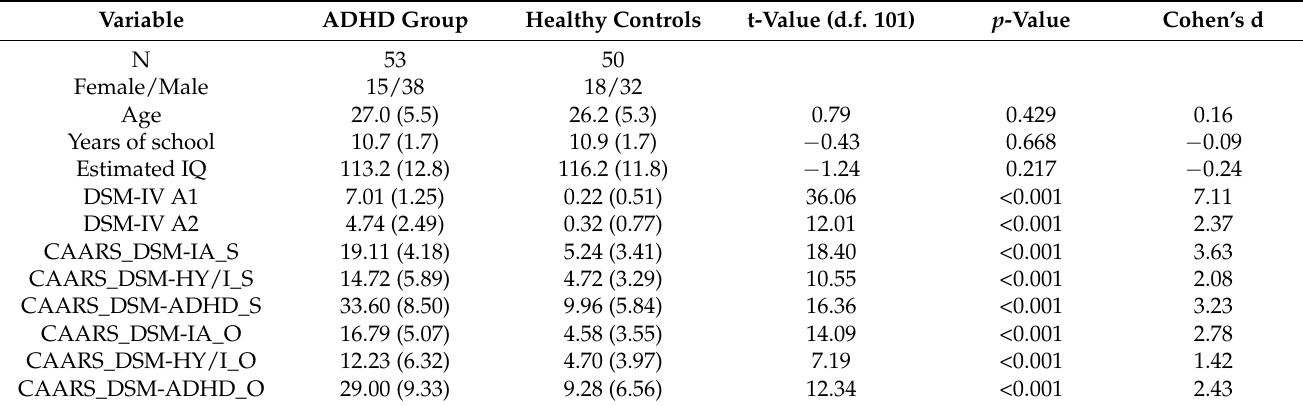
Table 1. Demographic and clinical characteristics of study participants at first visit